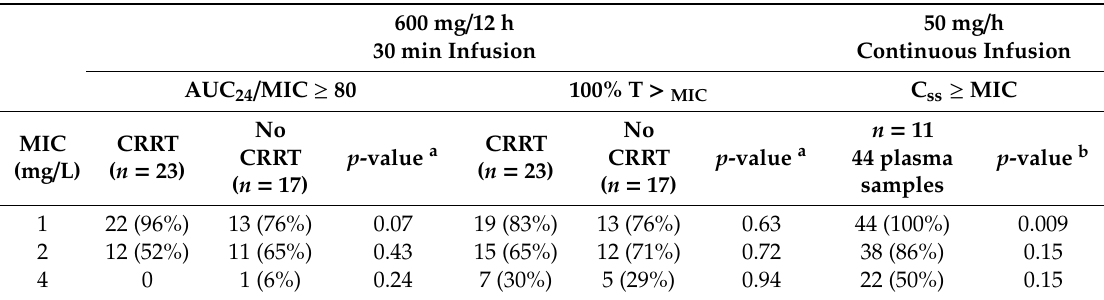
Table 4. Achievement rate of the PK / PD targets with linezolid administered as intermittent or as continuous infusion to critically ill